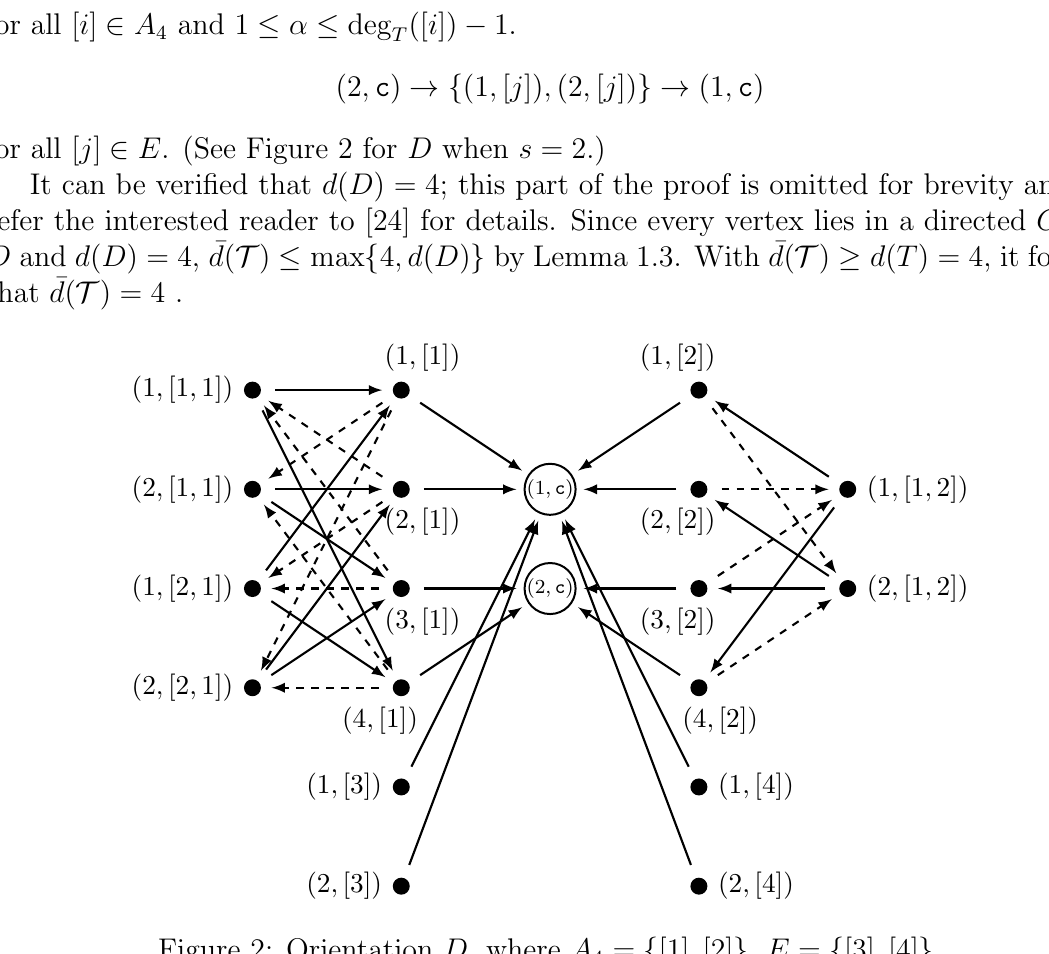
Figure 2: Orientation D , where A